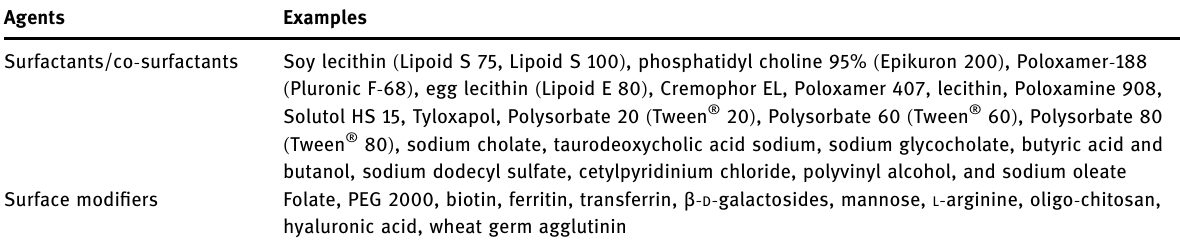
Surface modi fi